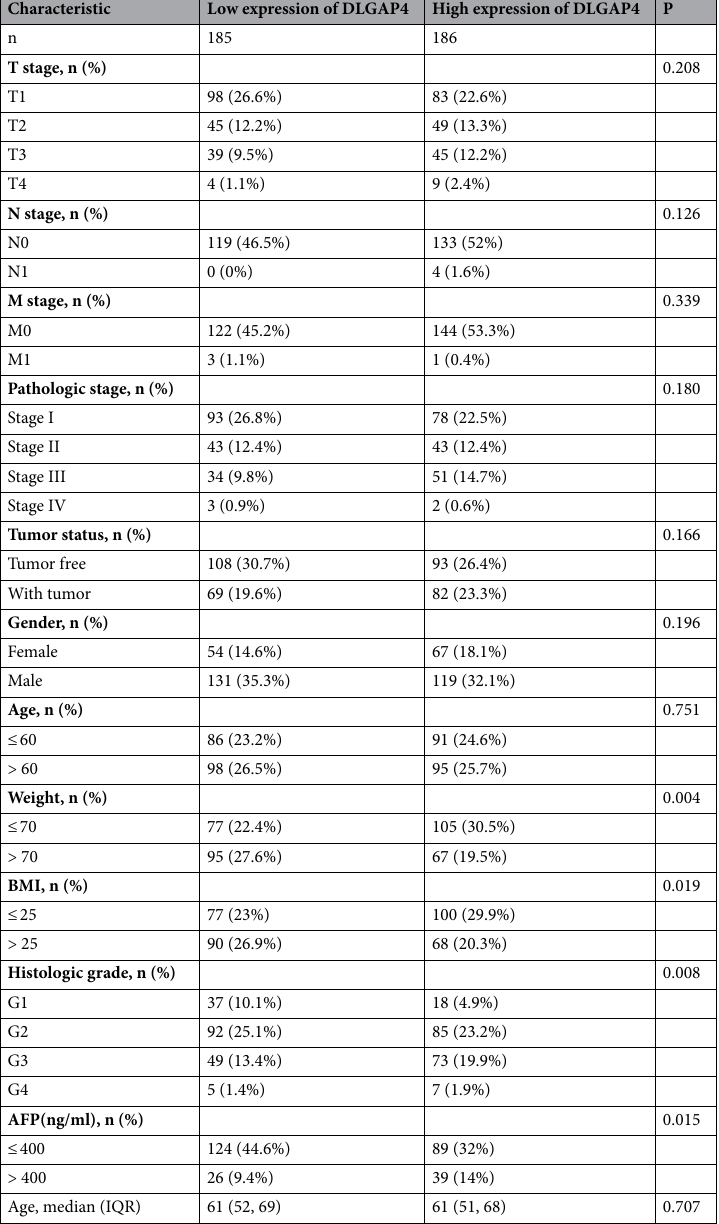
Table 1. Correlation between DLGAP4 expression and the clinicopathological features of the HCC